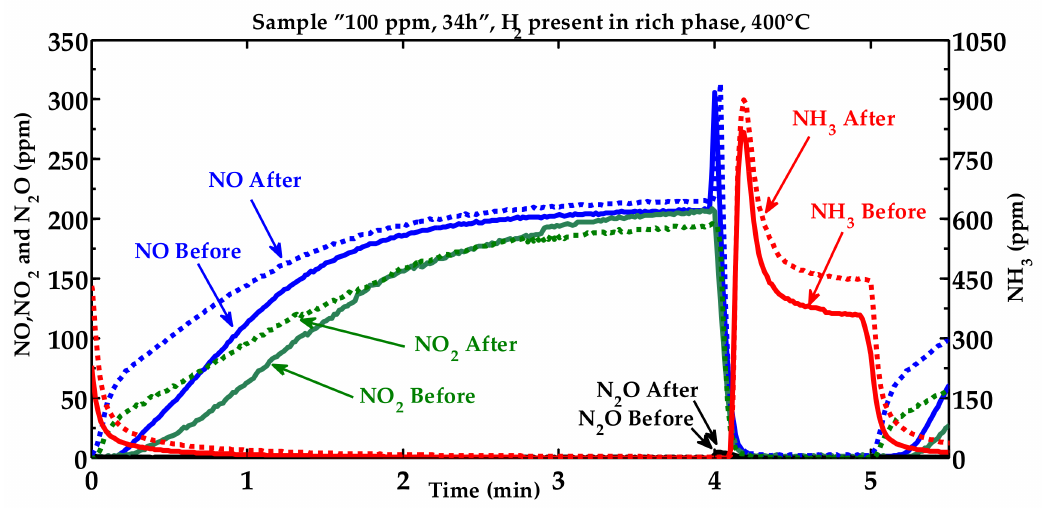
Figure 1. Measured outlet NO, NO 2 , N 2 O and NH 3 concentrations for the Pt/Ba/Al 2 O 3 sample “100 ppm, 34 h” before and after exposure to phosphorous (100 vol.-ppm H 3 PO 4 , 8 vol.-% O 2 , 5 vol.-% H 2 O at 200 ◦ C) in a flow-reactor experiment at 400 ◦ C. Lean phase; 400 vol.-ppm NO, 5 vol.-% H 2 O, 5 vol.-% CO 2 and 8 vol.-% O 2 . Rich phase; 400 vol.-ppm NO, 5 vol.-%H 2 O, 5 vol.-% CO 2 and 1 vol.-% H 2